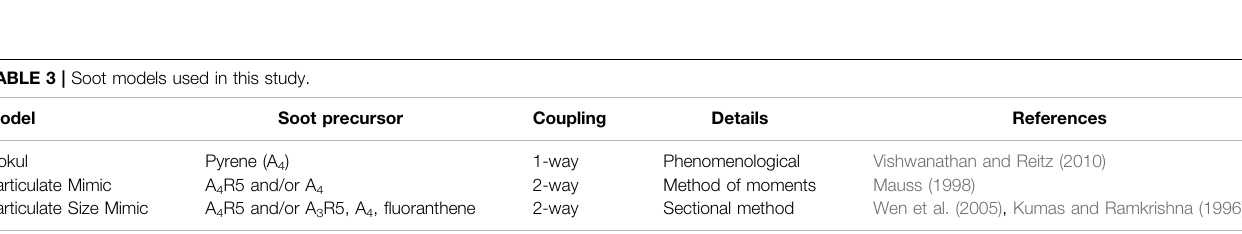
TABLE 3 | Soot models used in this